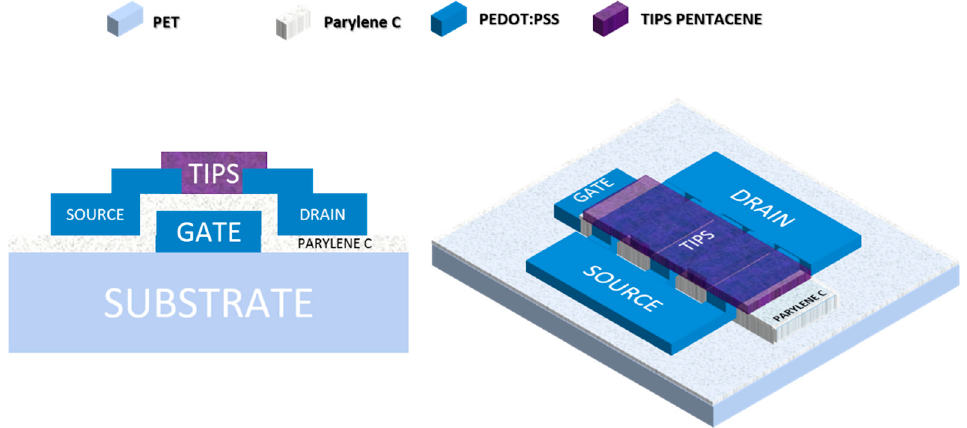
Figure 1. Section and 3D cartoon showing the Organic Field-Effect Transistor (OFET) structure and employed materials.